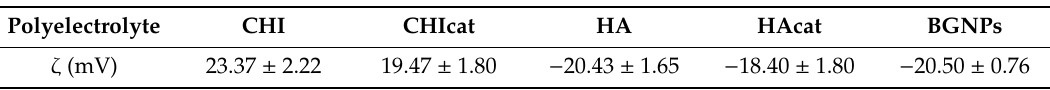
Table 1. Zeta potential measurements of CHI, CHIcat, HA, HAcat, and bioglass nanoparticles (BGNPs). Polyelectrolyte CHI CHIcat HA HAcat BGNPs